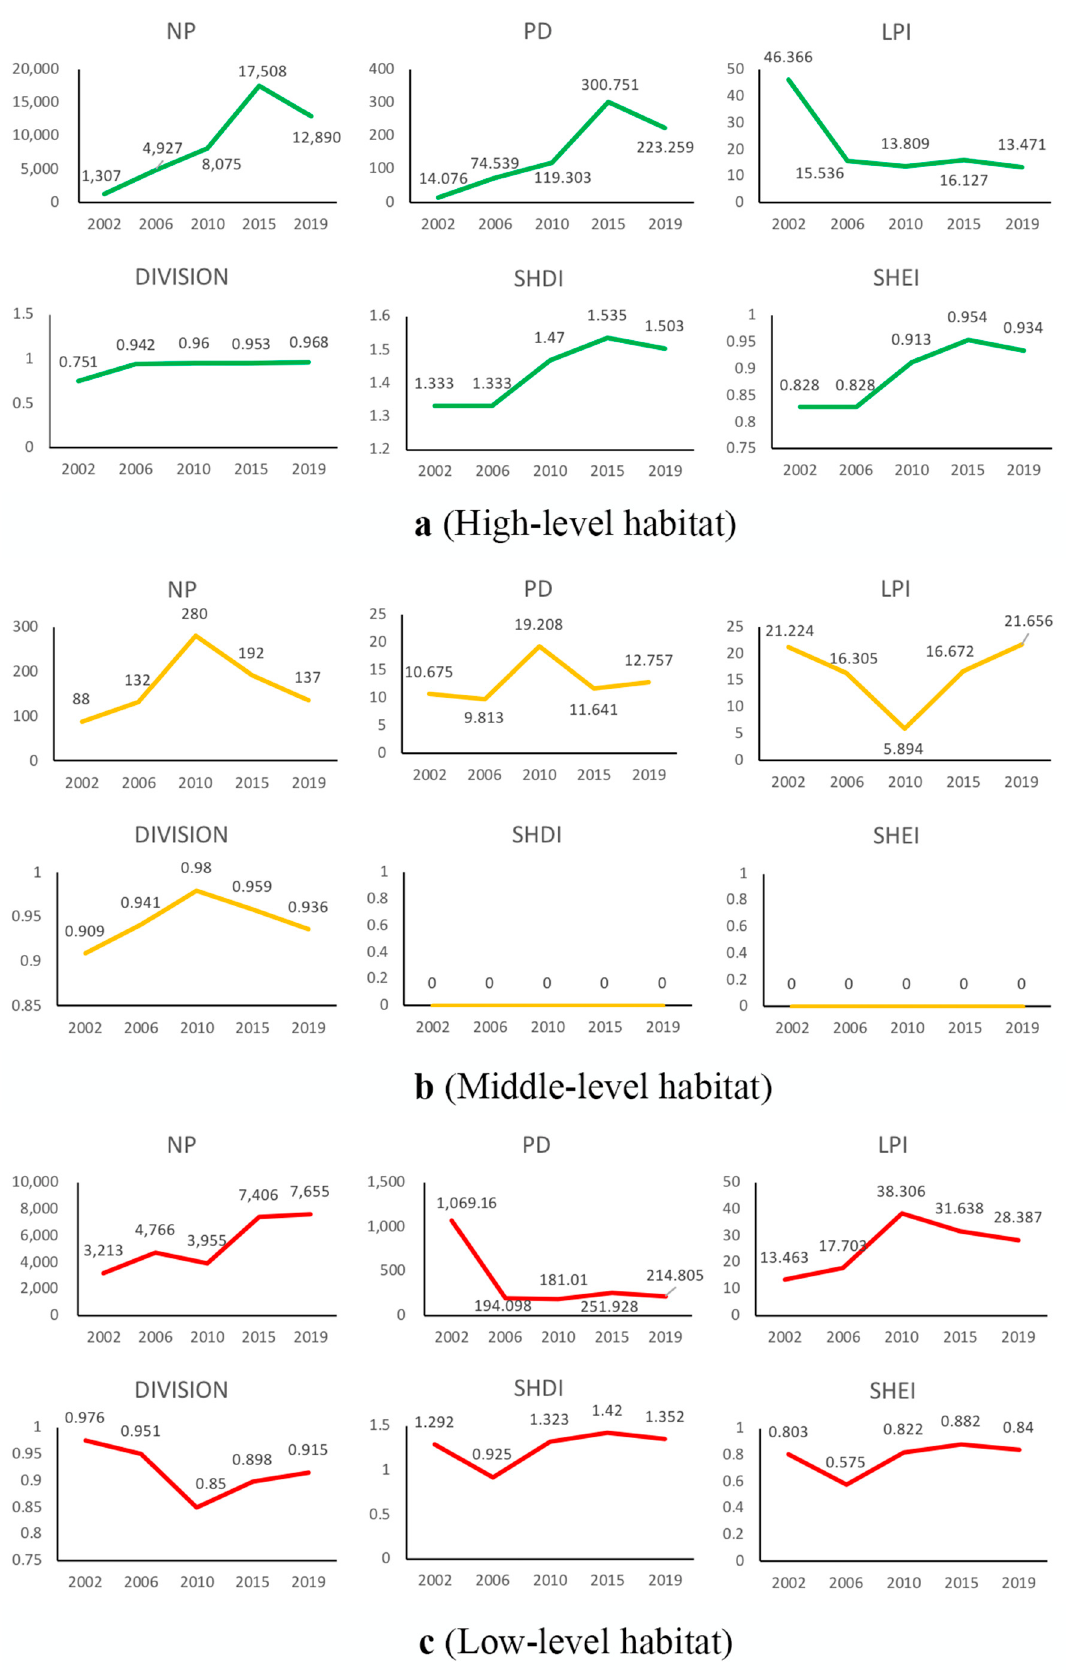
Figure 4. Landscape indexes of the Lin-Gang core area (2002–2019).